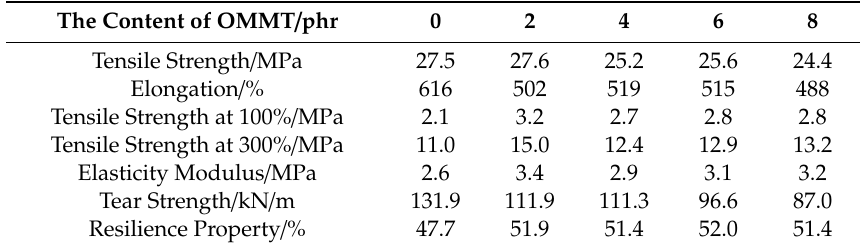
Table 2. The effects of OMMT contents on mechanical properties of vulcanized rubber. Table 2. The e ff ects of OMMT contents on mechanical properties of vulcanized rubber.